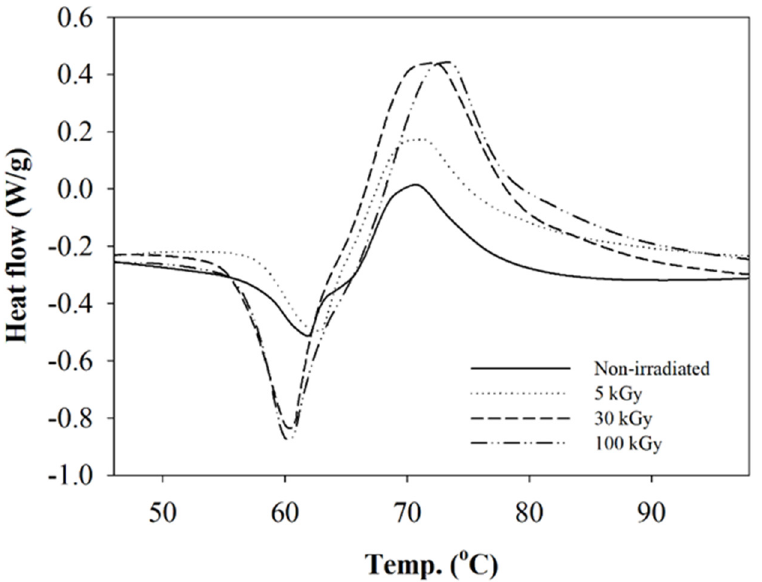
Figure 5. DSC thermogram exhibits the T g and T cc at different irradiation doses.